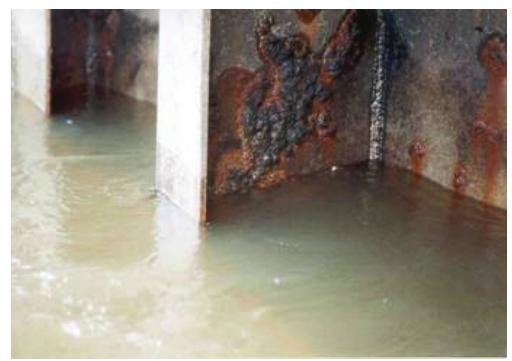
Figure 2: Corrosion inside a lock miter gate compartment.